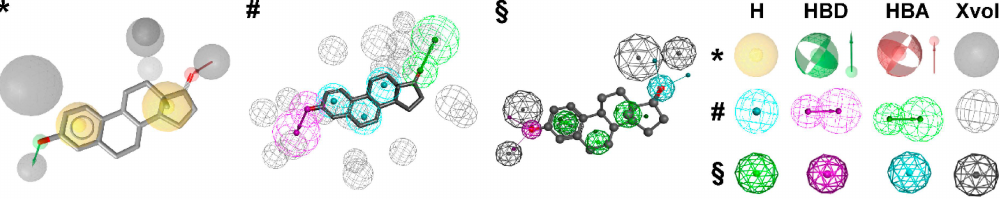
Figure 1. Pharmacophore models based on the estrogen equilin co-crystallized with 17 β -hydroxysteroid dehydrogenase type 1 (PDB entry 1EQU [5]) and generated with LigandScout [6] ( * ), Discovery Studio [7] (#), and Molecular Operating Environment (MOE) [8] ( § ). H, hydrophobic feature; HBD, hydrogen bond donor; HBA, hydrogen bond acceptor; XVols, exclusion